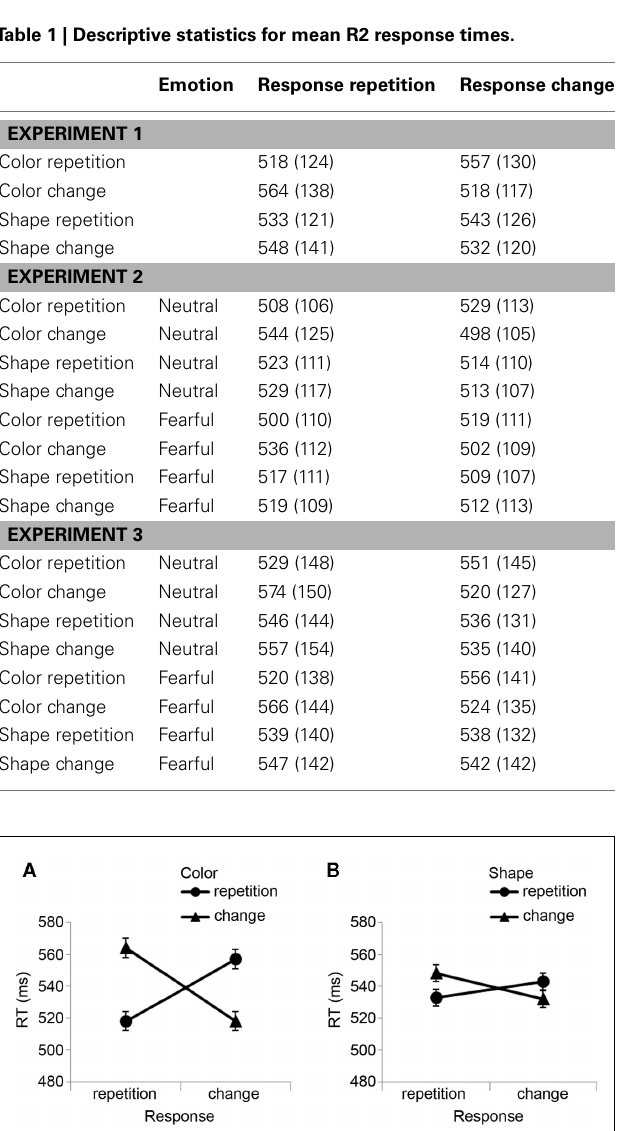
FIGURE 2 | Experiment 1 feature integration effects. Mean R2 response times ( ± SEM) in Experiment 1 are displayed as a function of (A) stimulus color and response transitions, and (B) stimulus shape and response